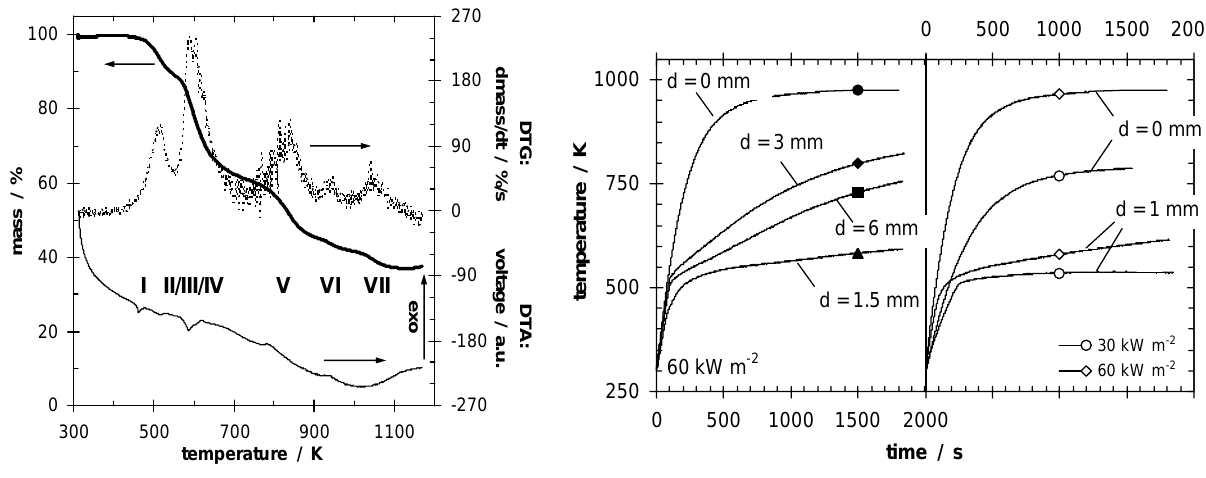
Figure 3. Decomposition (mass, mass loss rate and DTA signal) of an intumescent coating (on left), indicating endothermic char-forming decomposition steps at below 800 K. Temperature at the back of steel plates (right) protected by intumescent coating plotted against time, for different intumescent coating thicknesses (d) and